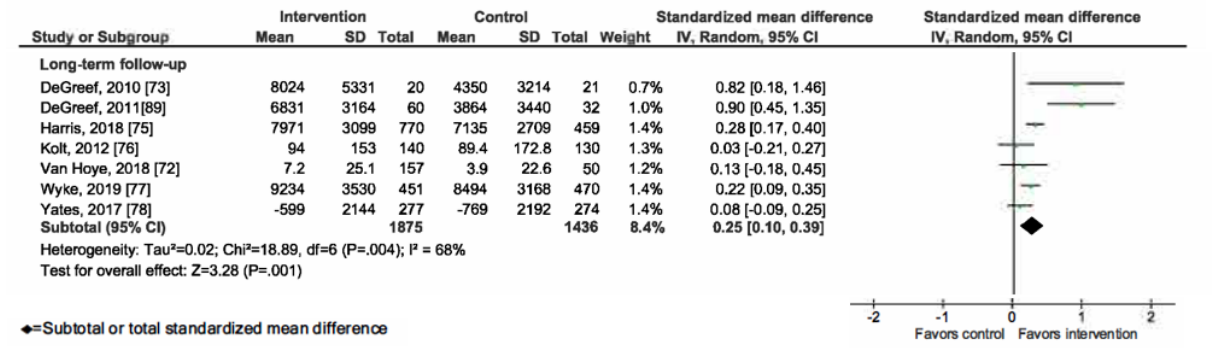
Figure 4. Primary outcome analysis for the outcome walking at timepoint long-term